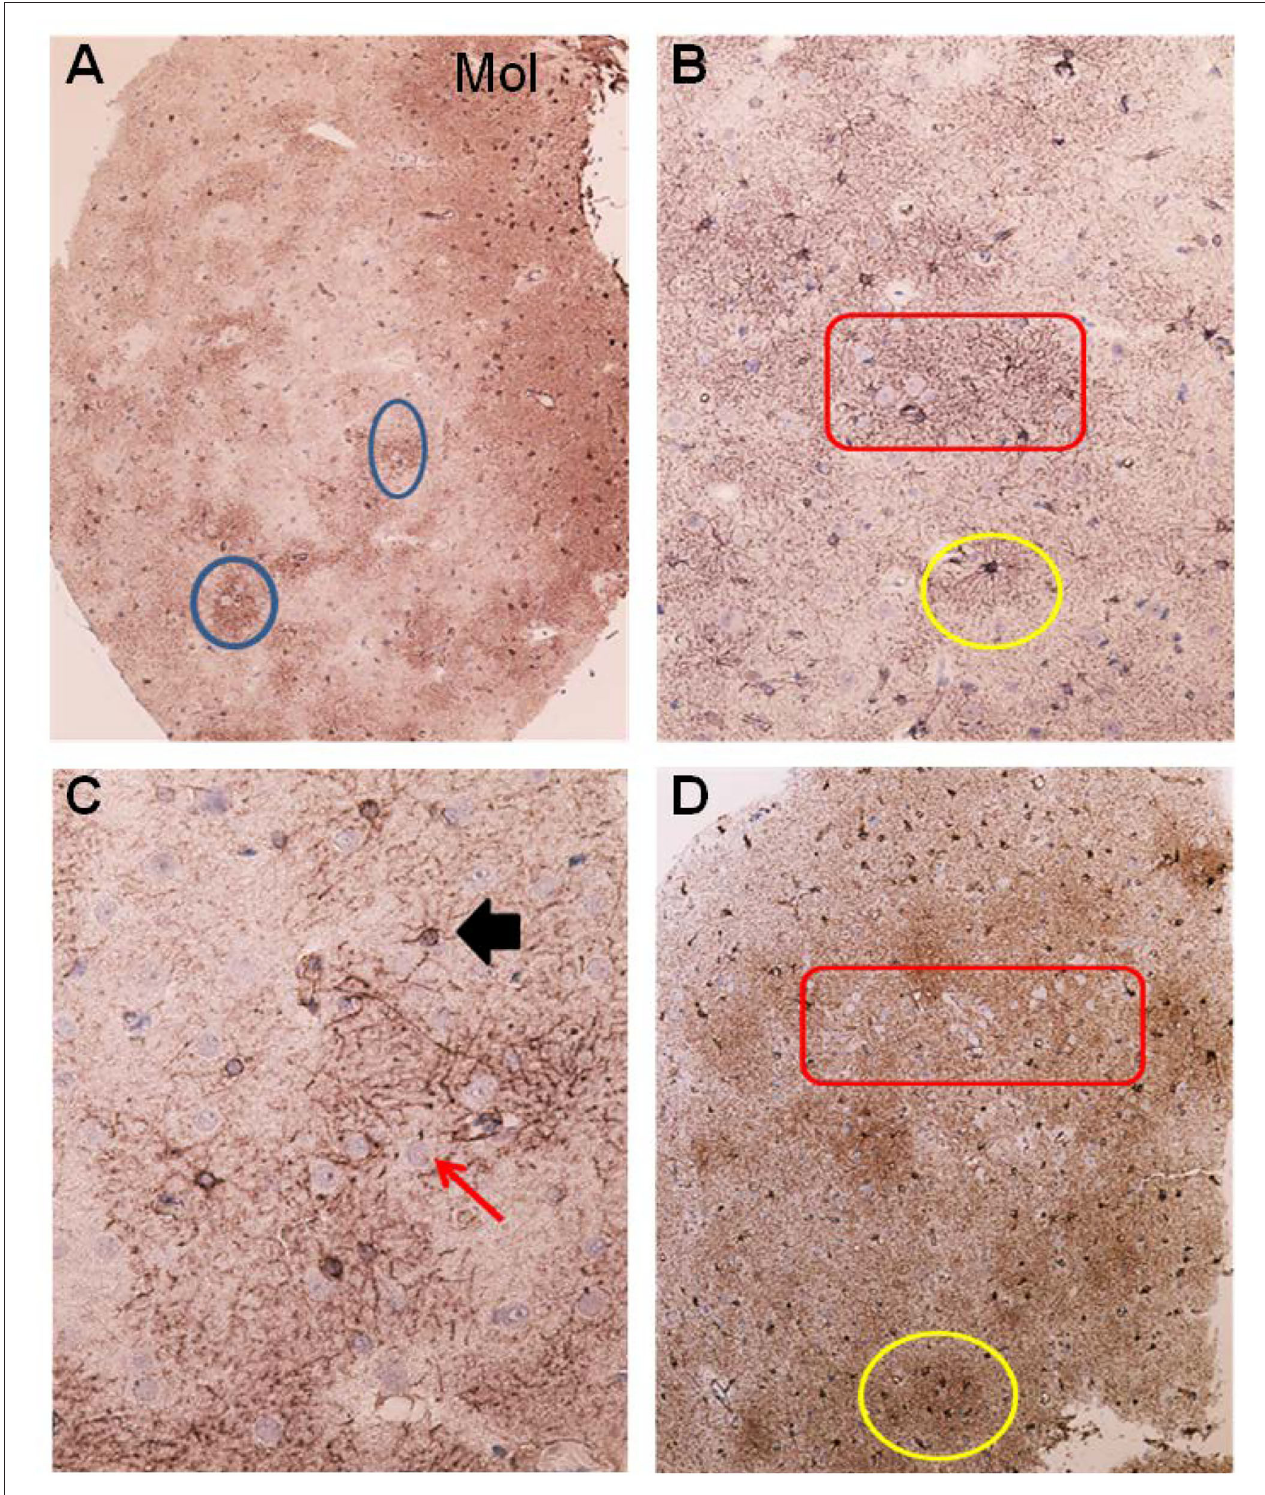
FIGURE 4 | Astrocytes visualized by GFAP IR in brain cortex biopsies from IIH patients. (A) Low magnification of a section of brain biopsy reveals a high prevalence of astrocytes in the subpial molecular layer (Mol; layer 1, also named Chaslin’s layer) looking like clusters of dark dots. Patches of astrocytes enclosing neurons are seen in cortical layers 2/3 (blue circles). (B) Clusters of hypertrophic astrocytes are seen enclosing unstained neurons (encircled by a red line). An apparently normal-looking astrocyte (outlined by yellow circle) with radiating slender processes without having any processes from adjacent glial cells entering its domain. (C) Neurons (red